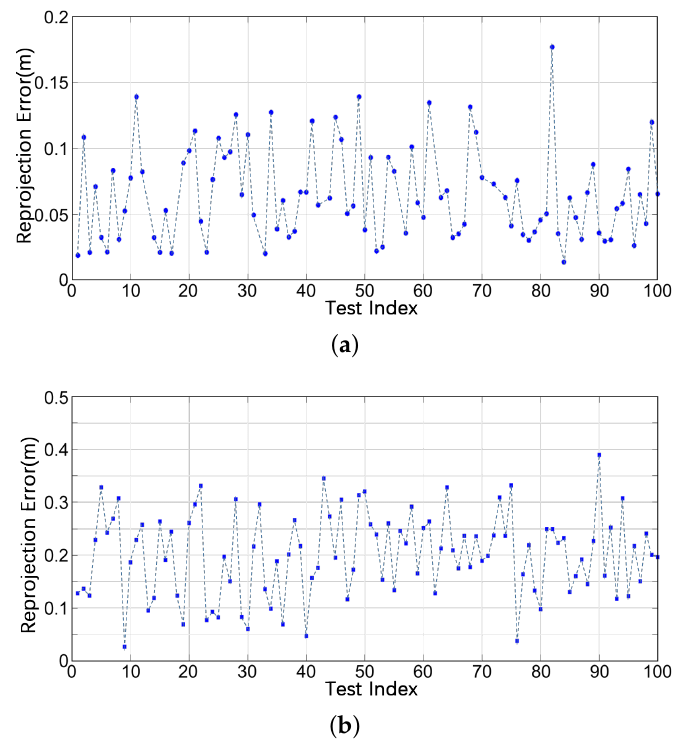
Figure 14. Reprojection error of the entire process on the ( a ) KITTI sequence 00 and ( b ) our campus